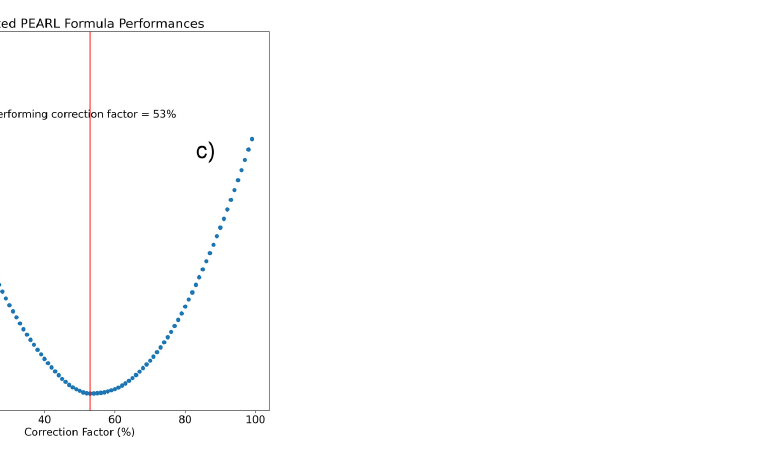
Figure 1 . Scatter graph showing mean absolute error (MAE) of prediction in relationship to increasing correction factor (CF) in Haigis formula ( a ), Barrett universal II formula ( b ), and PEARL-DGS formula ( c ). All three formulas exhibited the lowest MAE in the second eye when a CF of around 60% (vertical red line) was applied to the first-eye prediction error.